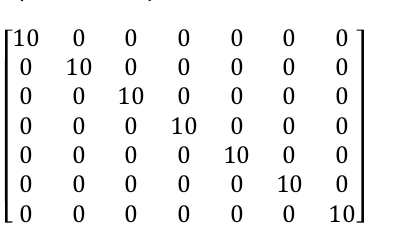
is the number of runs,